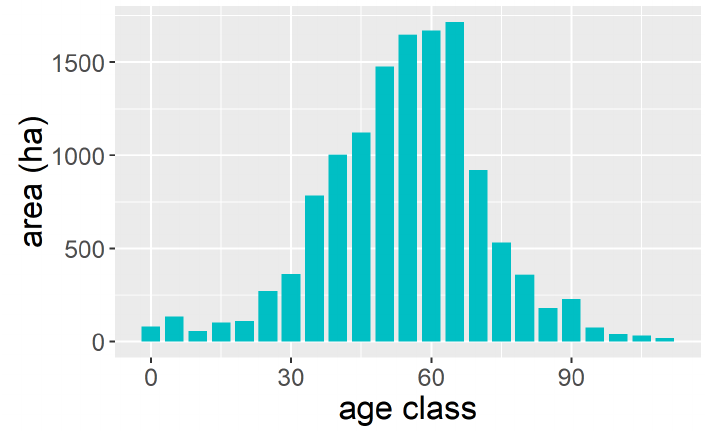
Figure 4. Current distribution of forest age classes in the study area: forest age was separated by every five years in each